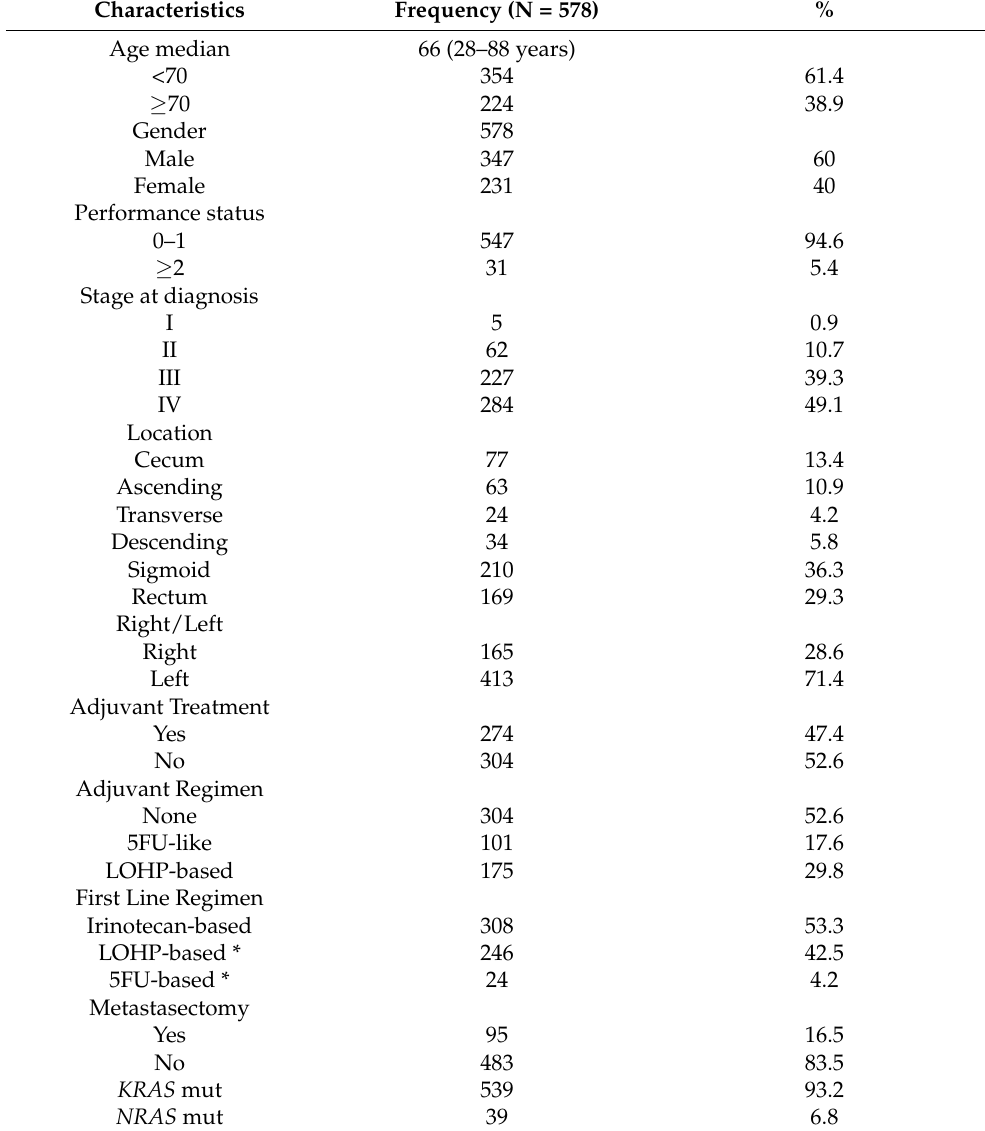
Table 2. Patients’ characteristics and